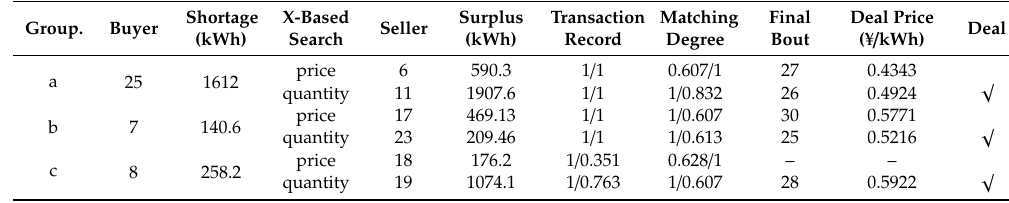
Table 2. Comparison of search strategies in three cases. Gro up.